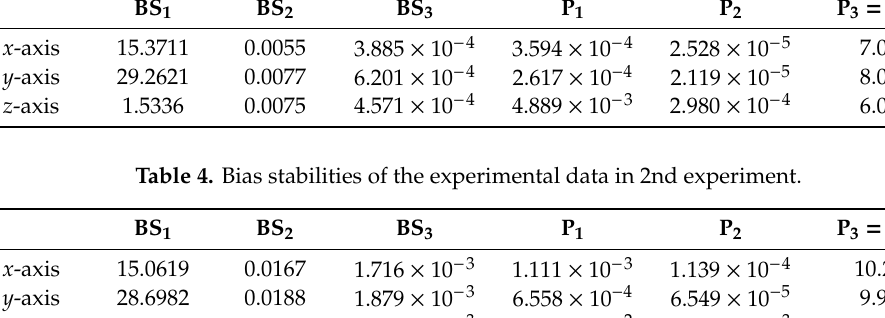
Table 4. Bias stabilities of the experimental data in 2nd experiment.